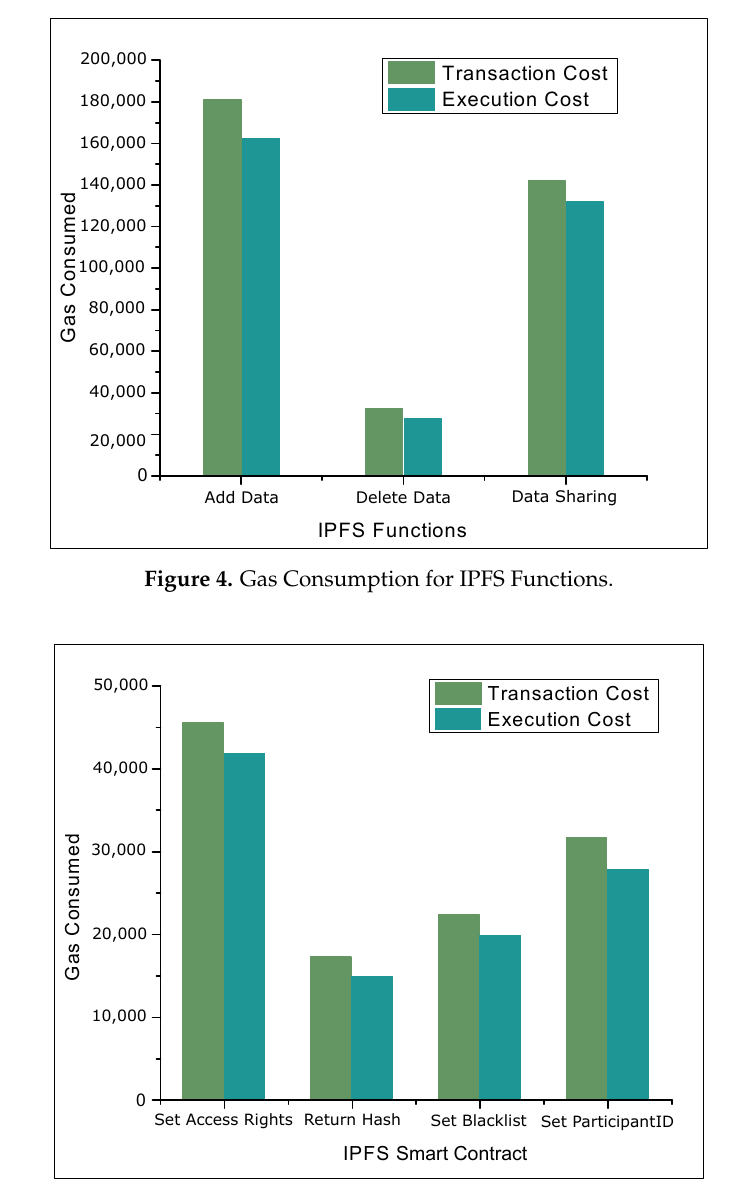
Figure 5. Gas Consumption for IPFS Smart